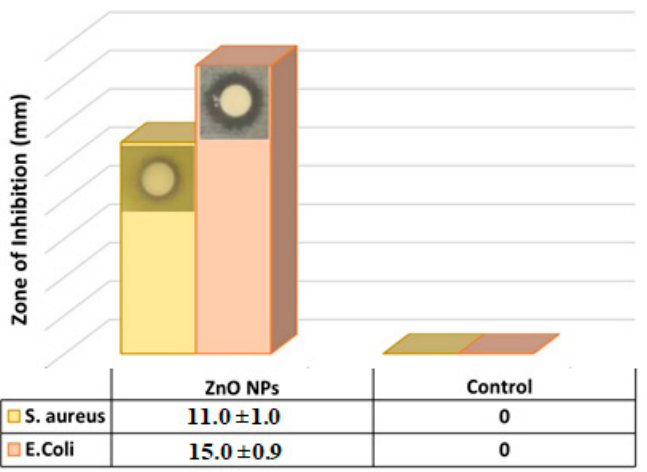
Figure 2. Scanning Electron Microscope ( A ) and transmission Electron Microscope ( B ) micrographs of ZnO NPs.